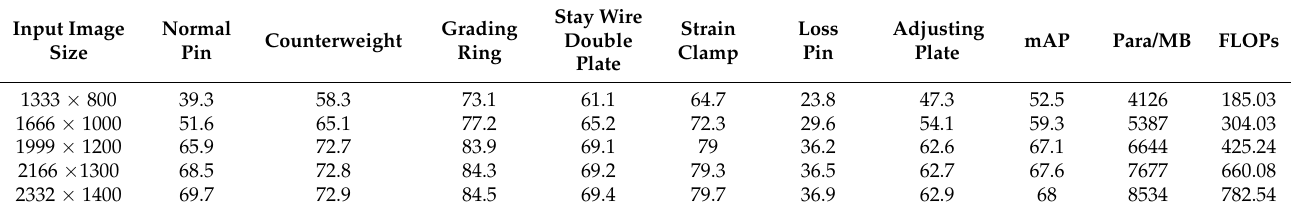
Table 4. Comparison of the detected objects with different image